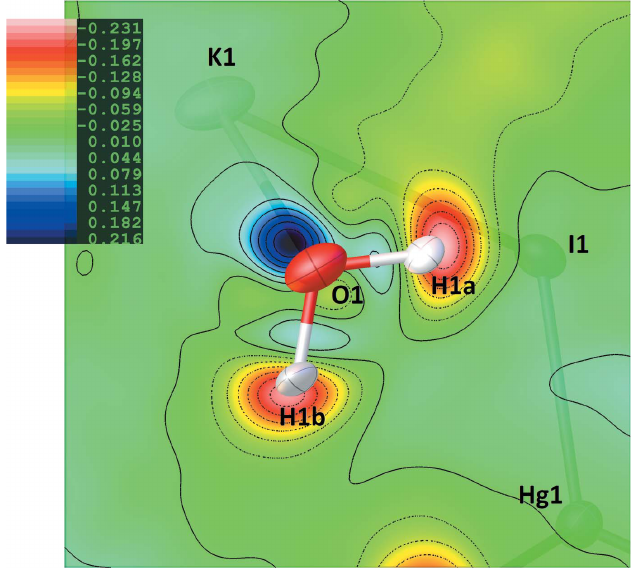
Figure 3 HAR – IAM dynamic deformation density map in the plane of the water molecule. Isolevel contours for positive density (e (cid:3) /A 3 ) are displayed as solid lines with the map coloured blue, while isolevel contours for negative density are displayed as dashed lines, with the map coloured red. The map was plotted with OLEX2 (Dolomanov et al. ,